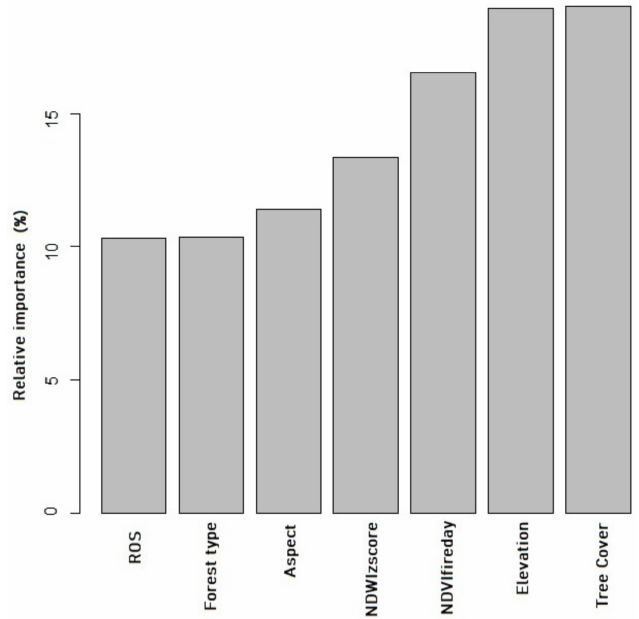
Figure 6. Relative importance of the explanatory variables used for modeling rdNBR. See Section 2 for data